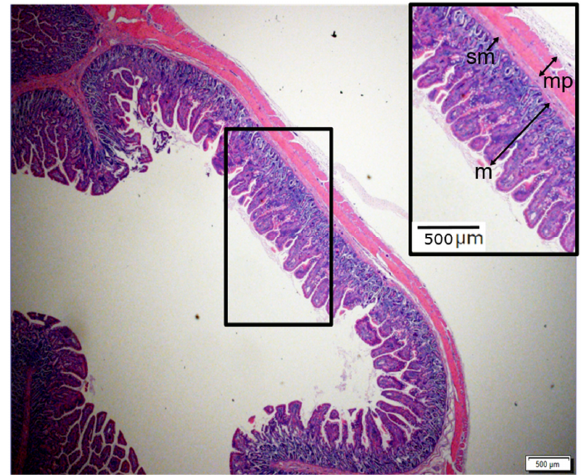
Figure 2. Representative cross-sectional light micrographs of H&E stained jejunum under normal (zero force) conditions. Black arrows indicate major layers of intestinal wall as mucosa (m), submucosa (sm) and muscularis propria (mp).